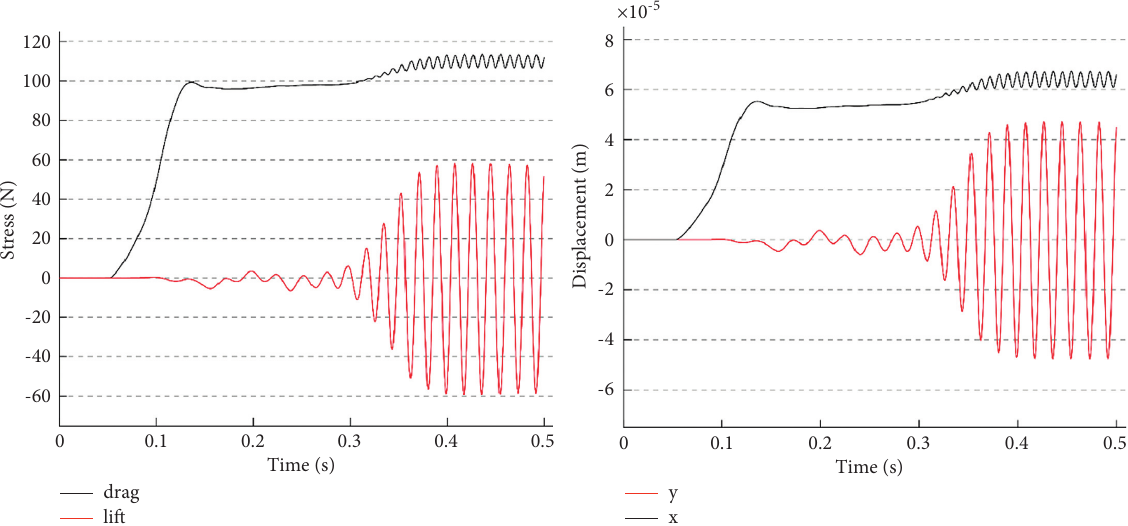
Figure 13: Time-domain graph of lift resistance and displacement.